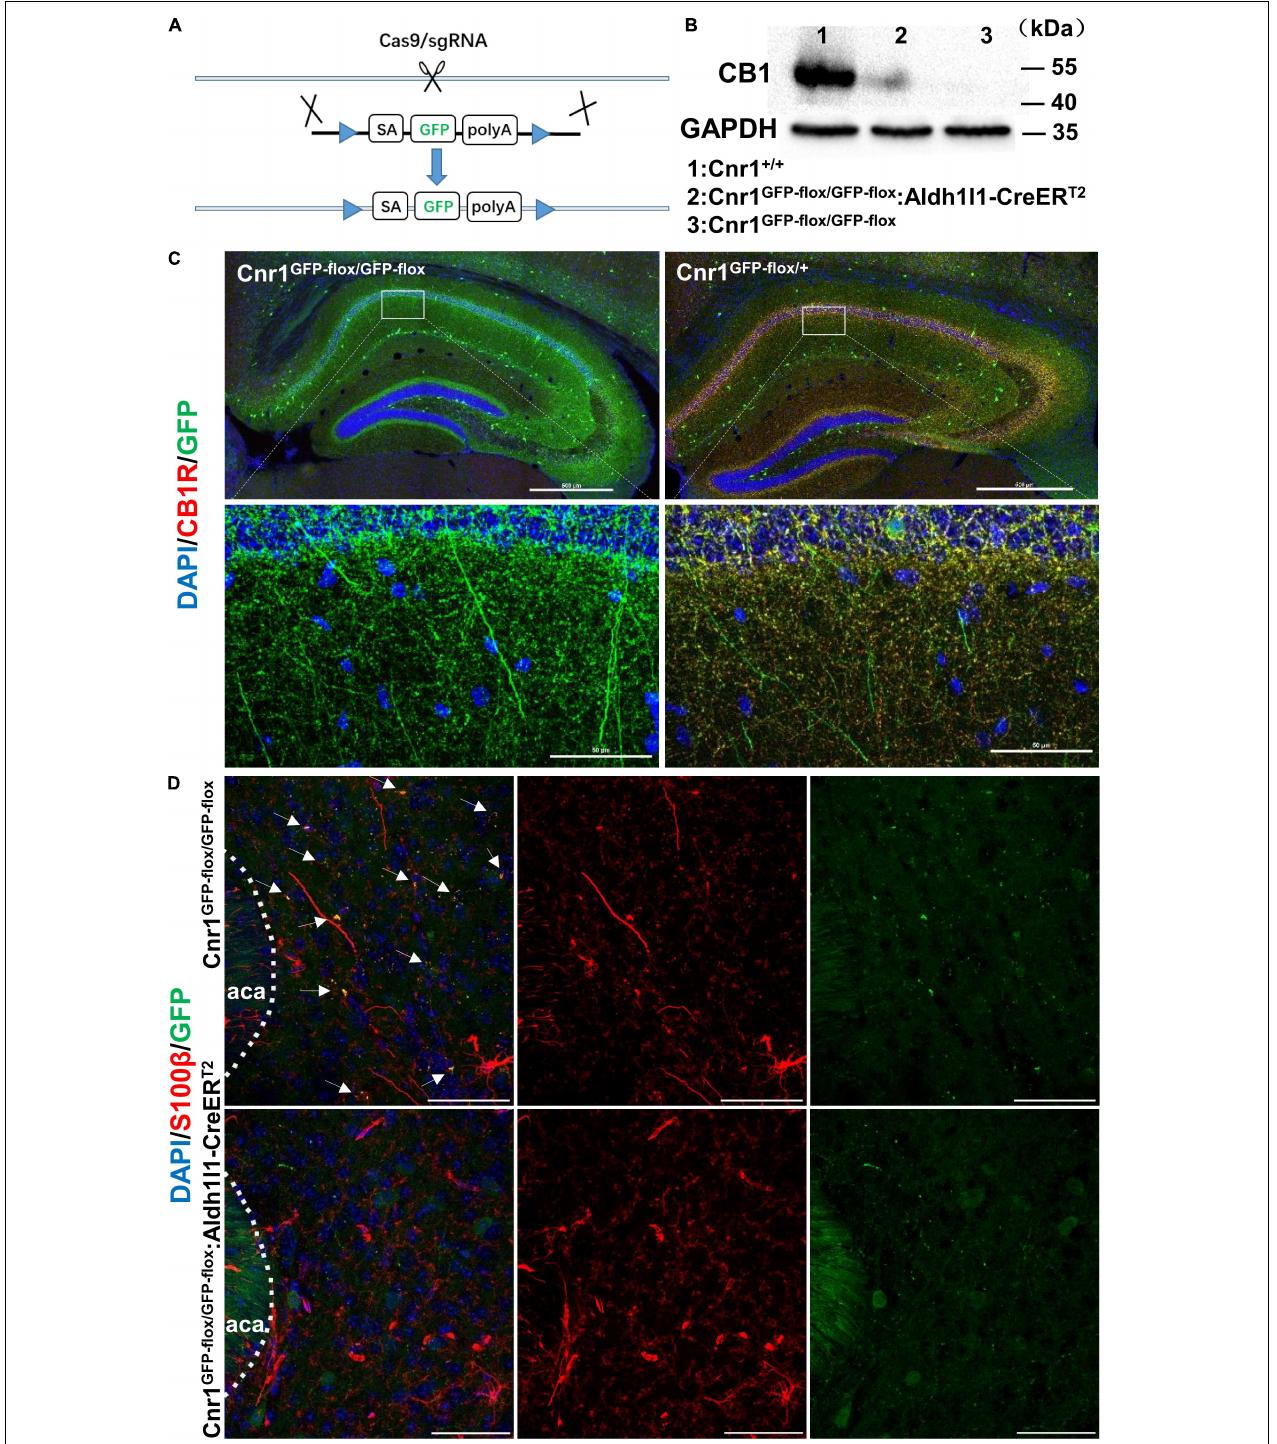
FIGURE 3 | Generation and characterization of Cnr1 GFP - flox / GFP - flox : Aldh1l1 -CreER T2 mice. (A) Schematic diagram showing the generation of Cnr1 GFP - flox / GFP - flox mice by insertion of loxp-SA-GFP-pA-loxp (GFP-flox) sequence into the intron of Cnr1 gene via the CRISPR/Cas9 system. (B) Western blotting showing the expression of CB1R in the nucleus accumbens of Cnr1 + / + , Cnr1 GFP - flox / GFP - flox , and Cnr1 GFP - flox / GFP - flox : Aldh1l1 -CreER T2 mouse brain. (C) Representative montage of the hippocampus showing the expression of CB1R in Cnr1 GFP - flox / GFP - flox and Cnr1 GFP - flox / + mice. Scale bar: above, 500 µ m; below, 50 µ m. (D) Representative montage of the nucleus accumbens showing the expression of GFP and S100 β in Cnr1 GFP - flox / GFP - flox and Cnr1 GFP - flox / GFP - flox : Aldh1l1 -CreER T2 double-transgenic mice injected with tamoxifen. Arrows indicate the co-expression of GFP and S100 β . Scale bar: 50 µ m.